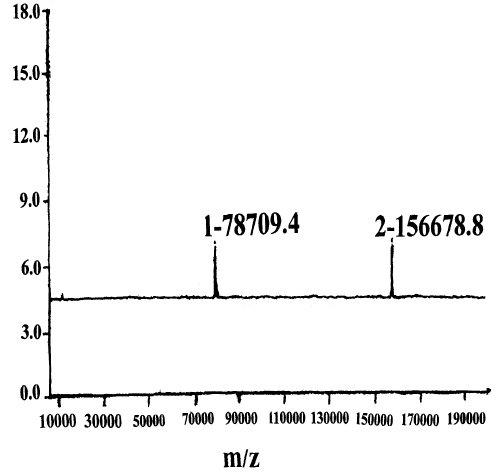
Figure 2. MALDI/TOF MS of MAb 1F2.The voltages of repeller and extractor were 30.0 kV and 9.3 kV.MS signals were obtained through 75 single